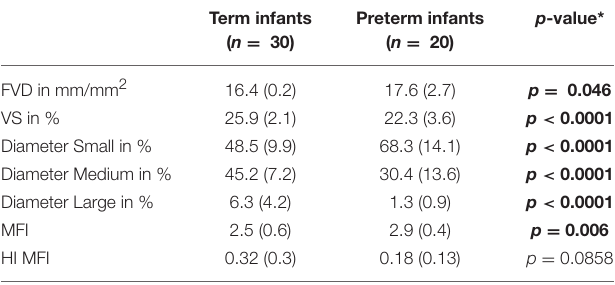
TABLE 2 | Microcirculatory data of the term and preterm group at the first